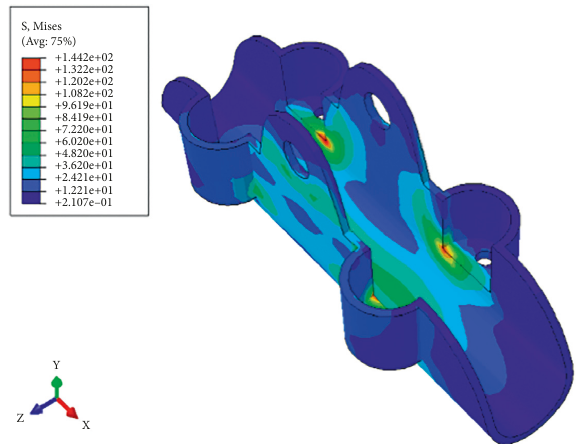
Figure 44: Stress cloud picture of suspension